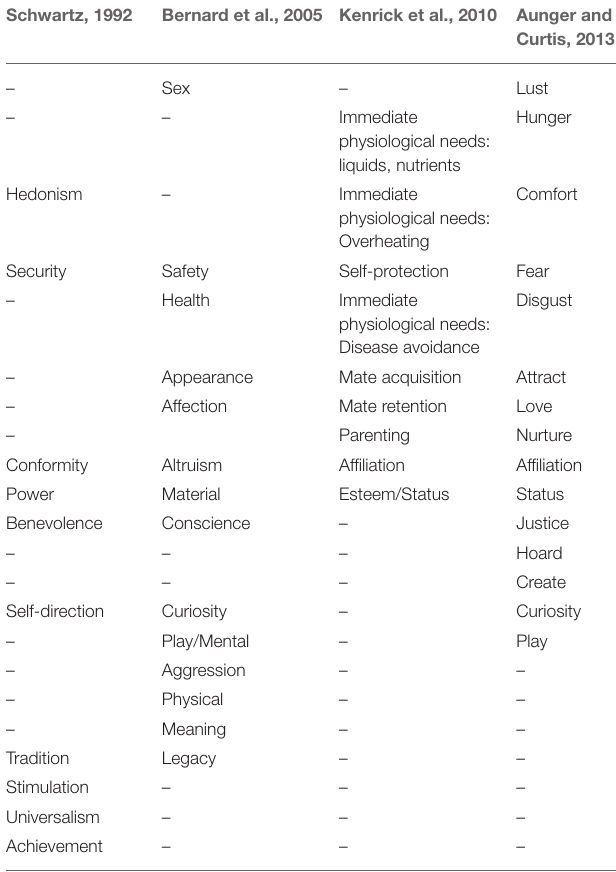
TABLE 7 | Four evolutionary motive